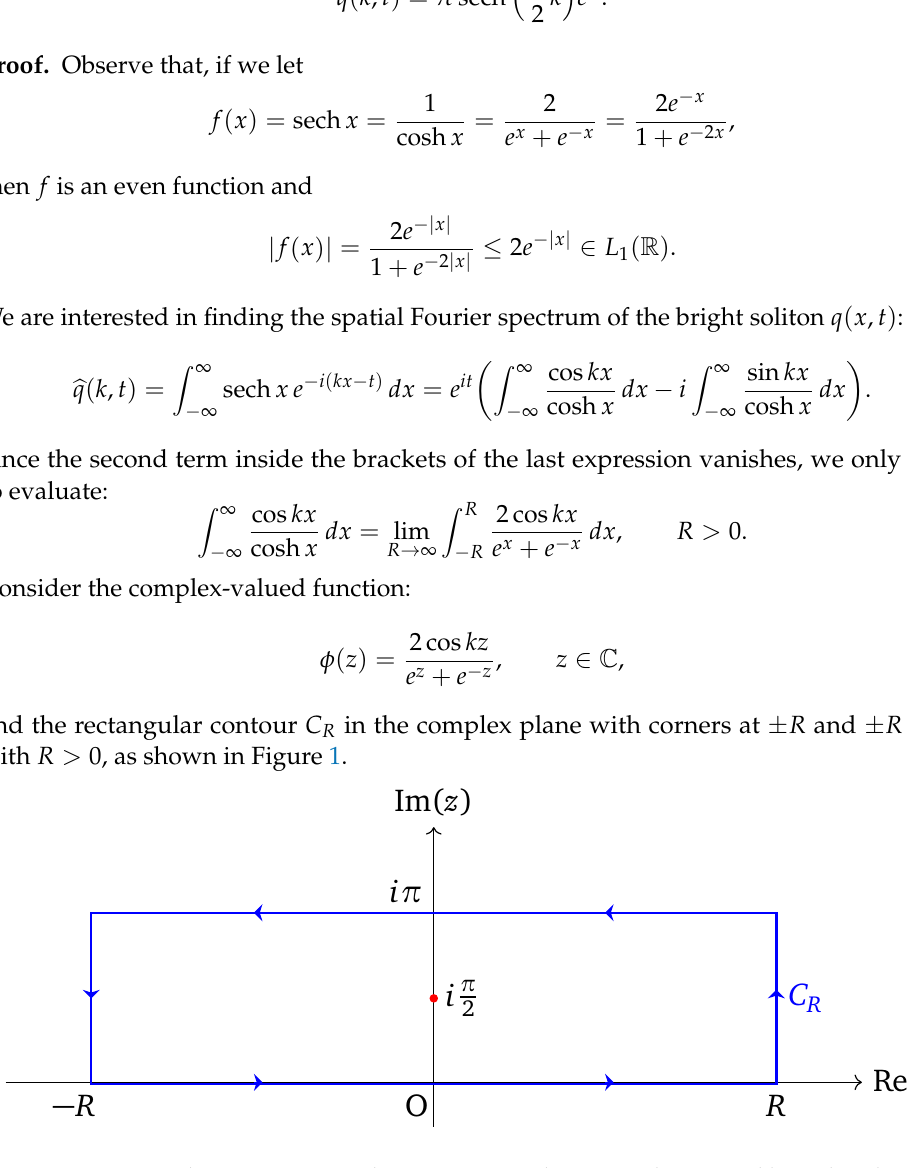
Figure 1: A rectangular contour C with corners R and R + i π determined by a closed, simple, piecewise smooth curve traversed in positive orientation. The function φ is holomorphic in an open connected domain containing the interior of C and its closure, except at the pole z = i π .